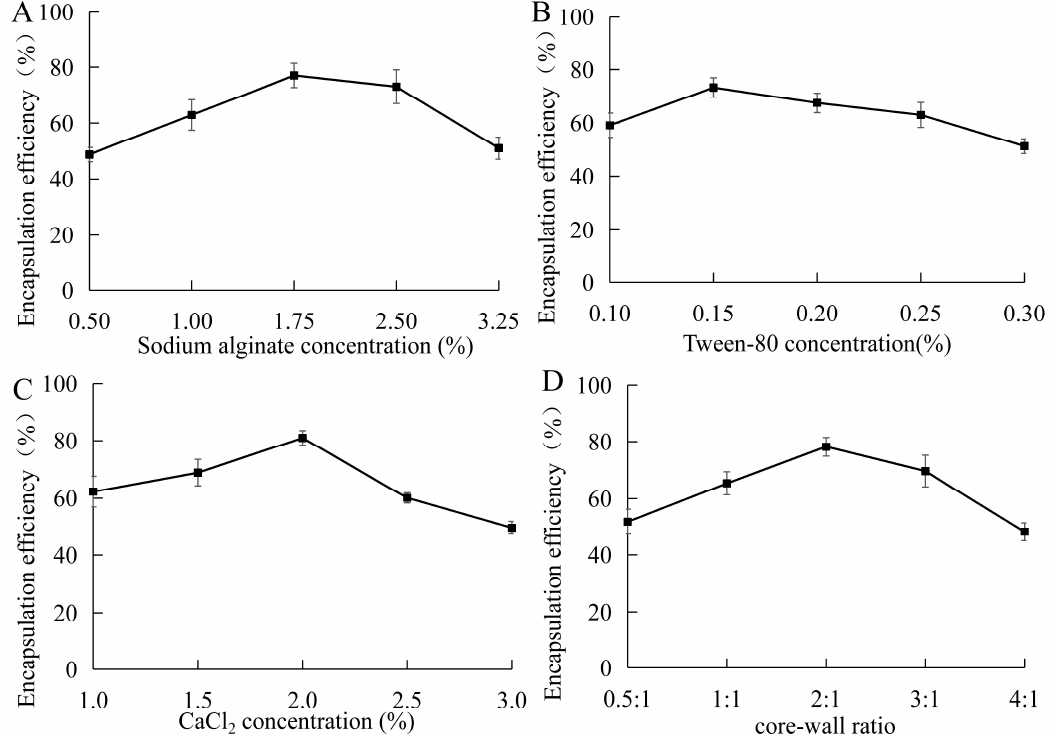
Figure 2. Effect of sodium alginate concentration ( A ), Tween-80 concentration ( B ), CaCl 2 concentra- tion ( C ), and core–wall ratio ( D ) on encapsulation efficiency. Each value represents mean ± standard deviation of three replicates.